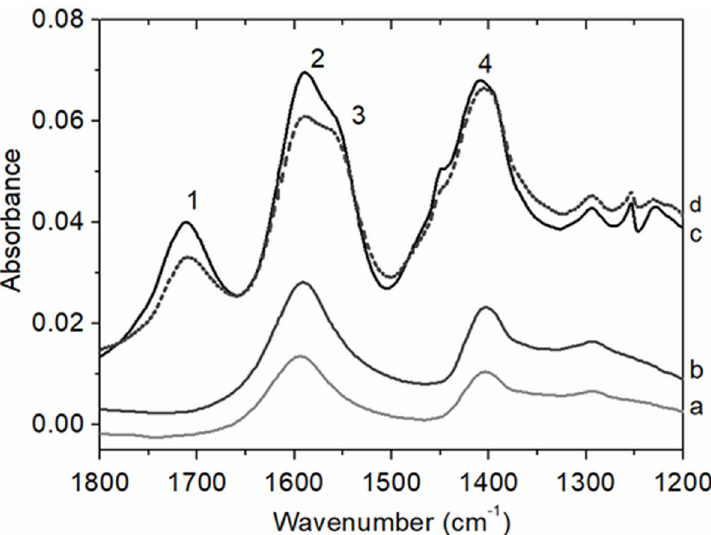
Fig 5. ATR-FTIR spectra of alginates (a: LV and b: HV3) and CLAMs (c: HV3 CLAMs and d: LV CLAMs) in the 1200–1800 cm -1 range. Both alginates and CLAMs spectra contain absorption peaks for asymmetric and symmetric COO- stretching vibration (centered at 1595 cm -1 (peak 2) and 1410 cm -1 (peak 4), respectively) indicating the presence of alginate salts. The appearance of an absorption peak for carboxylic acid at 1710 cm -1 (peak 1) in the CLAMs spectra is due to the presence of alginic acids. Additionally the peak centered at 1550 cm -1 (peak 3) in the CLAMs spectra indicate the formation of an amine salt. LV and HV3 alginates, as well as the CLAMs formed with these alginates absorbed strongly at 1595 cm -1 (peak 2) and 1410 cm -1 (peak 4) due to the symmetric and asymmetric stretching of the ionized carboxylate. The presence of COO - groups are expected in the sodium alginates (-COO - Na + ) [36], and in electrostatically crosslinked CLAMs (-COO - Ca ++ ). In the CLAMs spectra (but absent in the alginate spectra) is an additional strongly absorbing peak centered at 1710 cm -1 (peak 1) indicating the presence of carboxylic acid. Under high acid concentrations and as the pH of the surrounding solution approaches the pK of alginates, protonation of the a carboxyl groups occurs. The FTIR spectra of CLAMs indicate that a fraction of the carboxyl groups become protonated during formation; i.e., alginic acid is formed. While the formula- tion also contained succinic acid, the absorption maximum of its carbonyl peak is at 1685 cm -1 and offset from that of the CLAMs sample (S1 File).